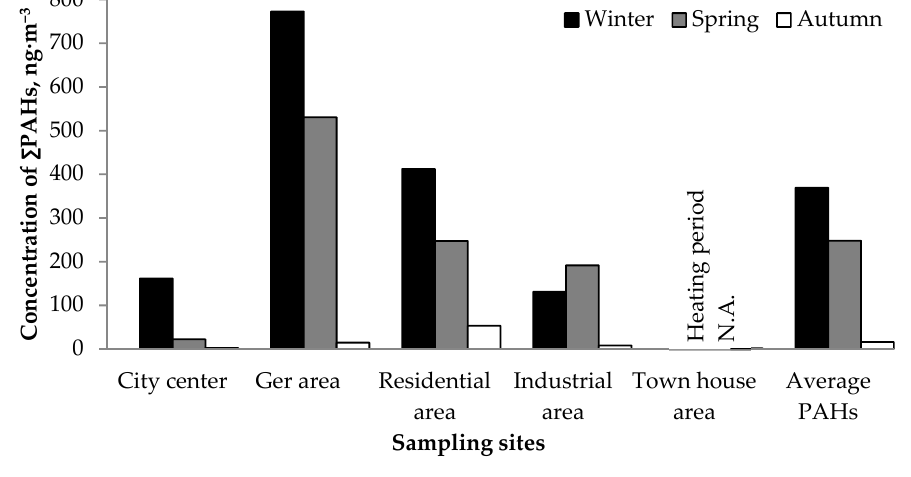
Figure 2. Atmospheric concentrations of PAHs in Ulaanbaatar City.